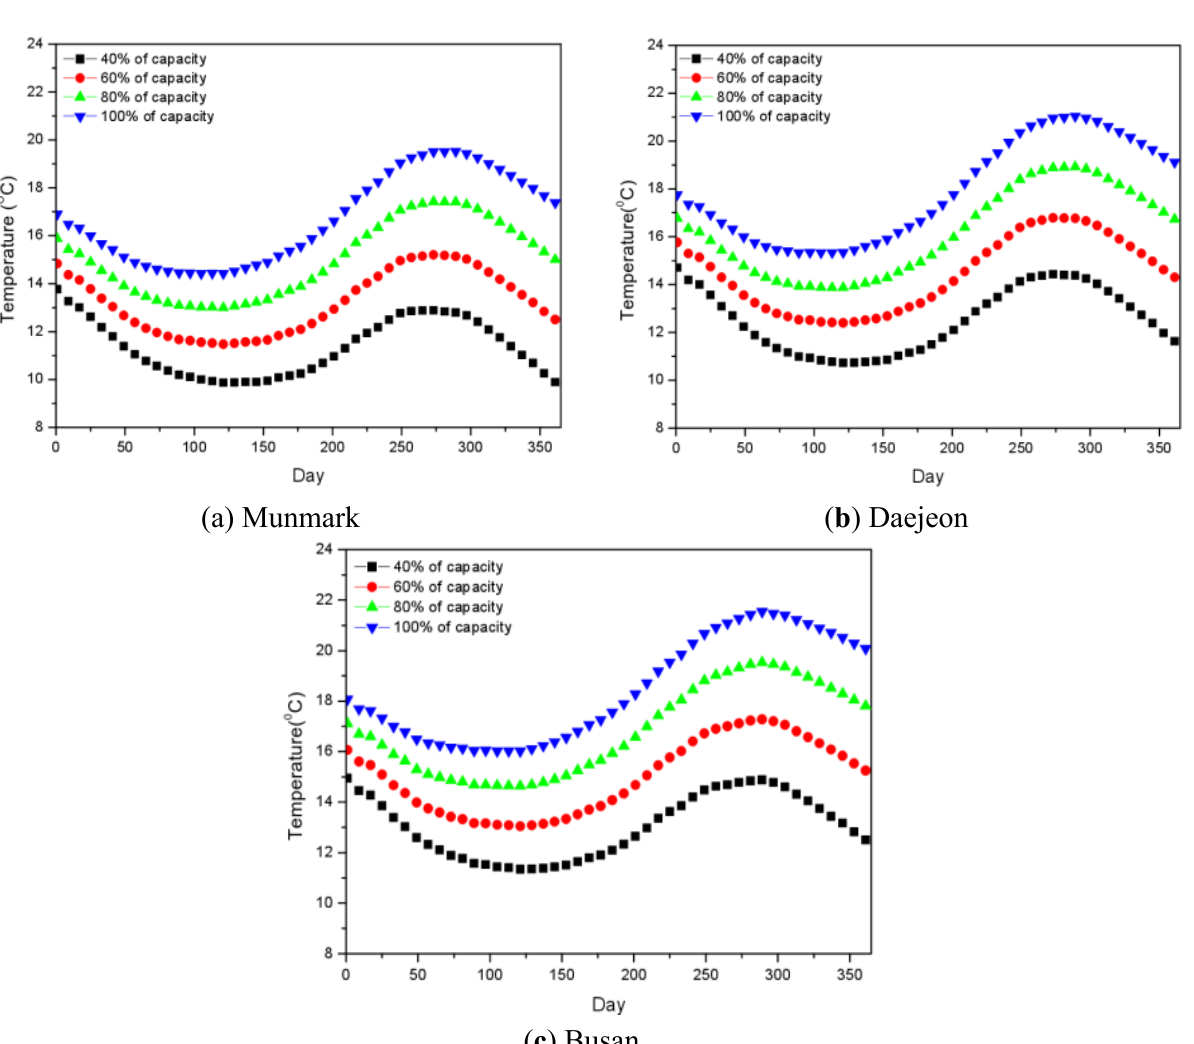
Figure 6. Effect of occupancy on the ground mean temperature. ( a ) Munmak; ( b ) Daejeon; ( c )